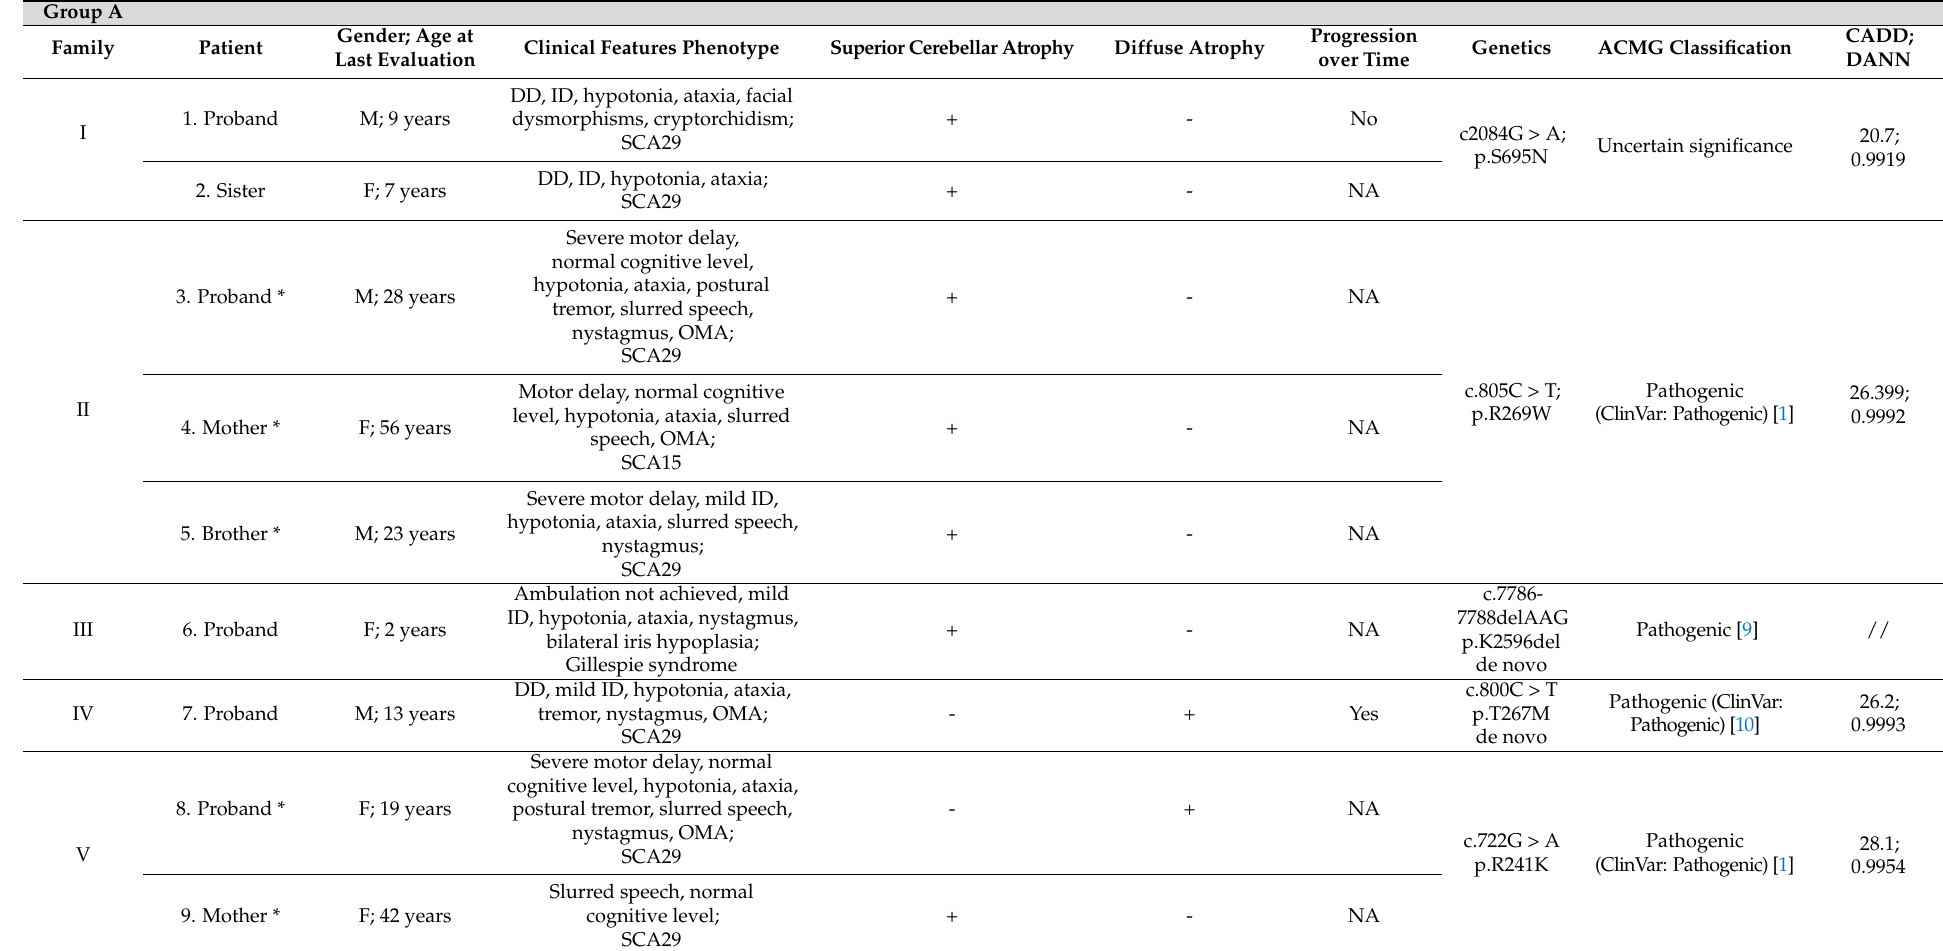
Table 1. Clinical, neuroradiological and genetic features of enrolled